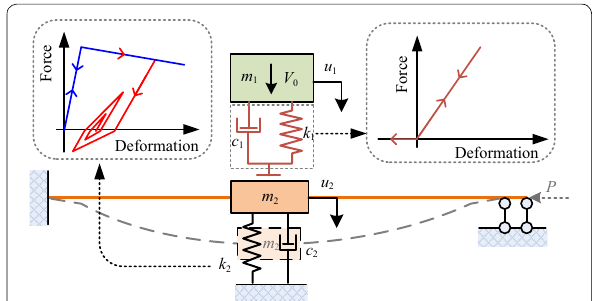
Fig. 1 Simplified Two-DOF model of axially-loaded circular RC